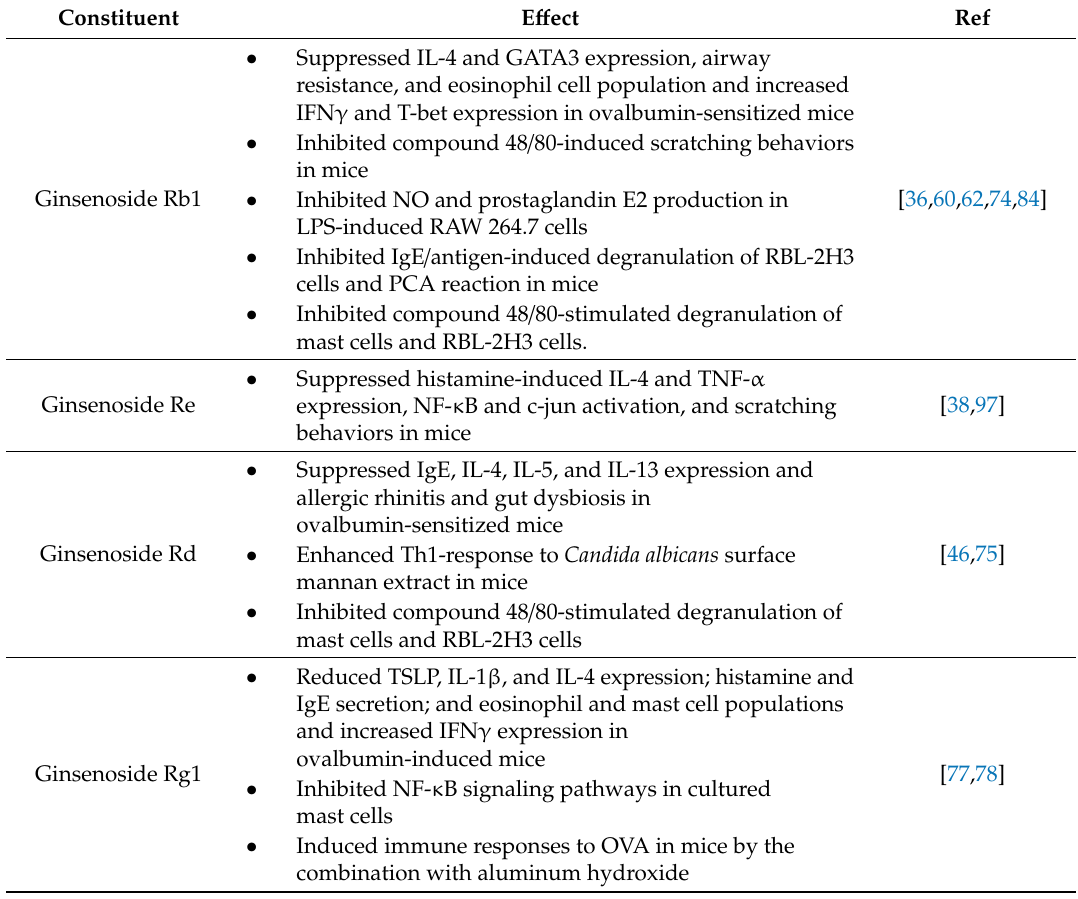
Table 3. Summary of ginseng constituent e ff ects on allergic